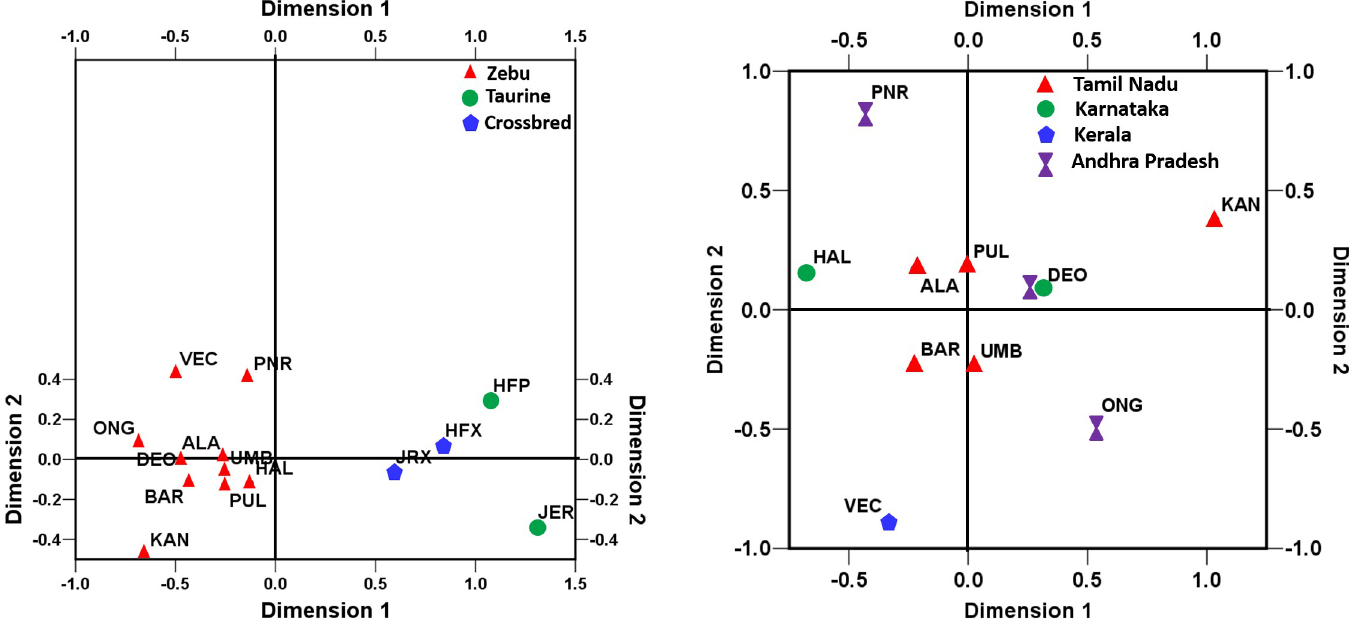
Fig 3. Multidimensional scaling display of pairwise F ST among South Indian cattle (a) draught type zebu, taurine and crossbred cattle (normalized raw stress = 0.008) and (b) among draught type zebu cattle only (normalized raw stress = 0.029).